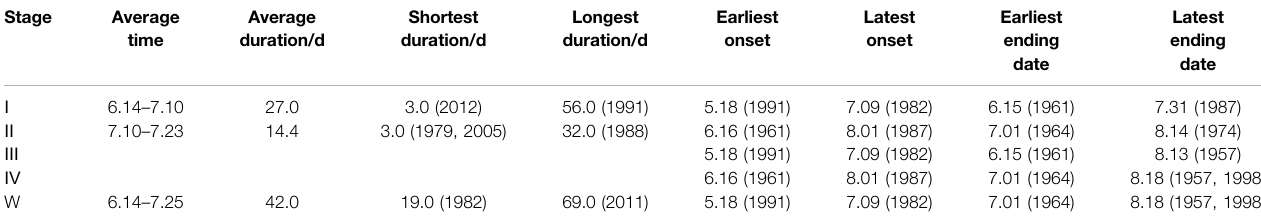
TABLE 1 | Characteristics of Meiyu and Huang-Huai rainy season during 1957 – 2020 in Anhui Province. Stage Average